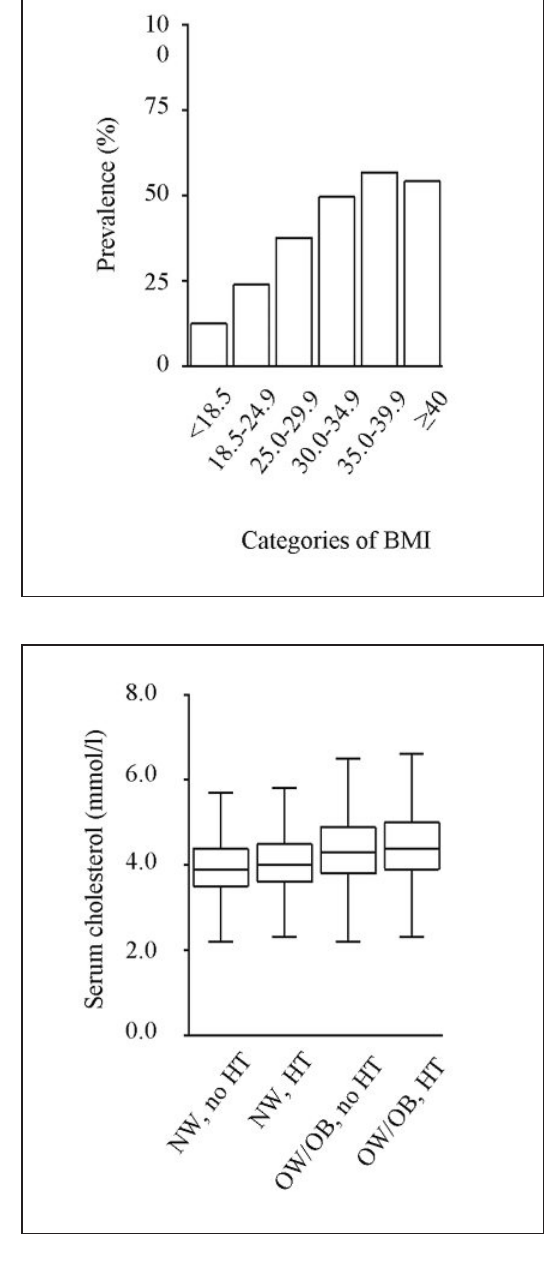
Serum cholesterol in categories of blood